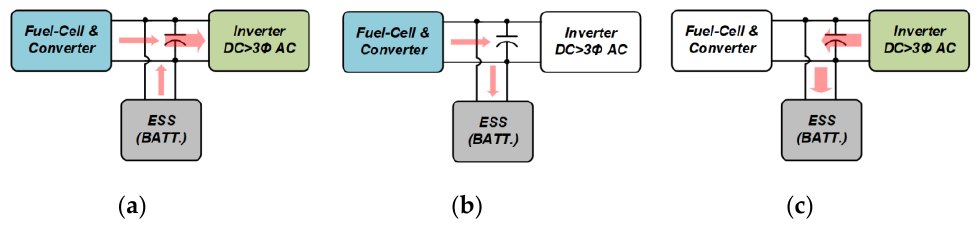
Figure 2. Power transmission mechanisms according to the driving pattern: ( a ) powering; ( b ) coasting; ( c ) braking.